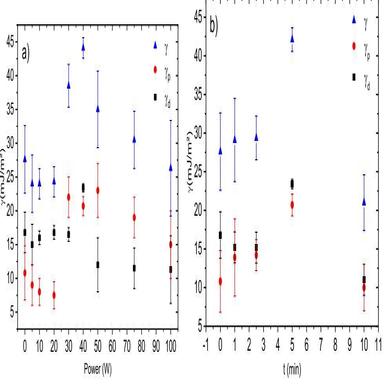
Surface free energy (γ), its polar (γp) and dispersive (γd) components of CF treated in O2 plasma a) for different applied powers (t = 5 min); b) for varying exposure time (P = 40 W).